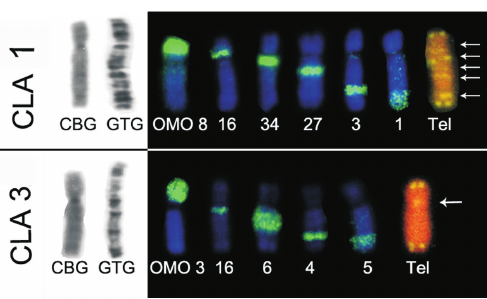
Figure 3 - CBG and GTG-banding pattern and hybridizations with OMO and telomeric probes in chromosomes CLA 1 and CLA 3 of C. langguthi